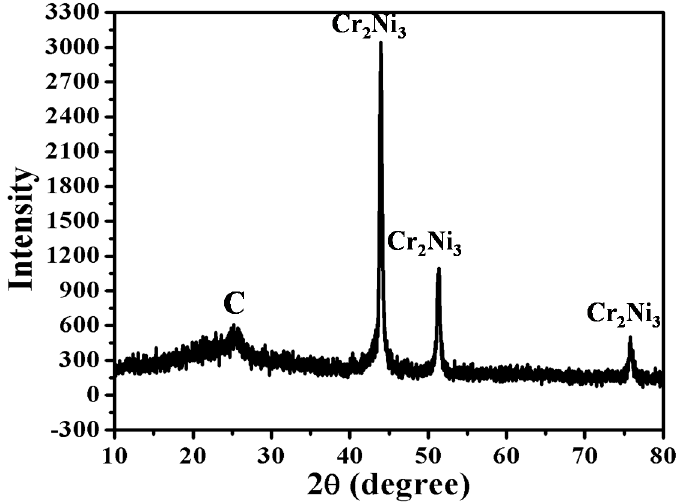
Figure 2. X-ray diffraction (XRD) pattern for the electrospun NiAc/CrAc/PVA NF mats after Figure 2. X-ray di ff raction (XRD) pattern for the electrospun NiAc / CrAc / PVA NF mats after calcination calcination at 800 °C in inert atmosphere. at 800 ◦ C in inert